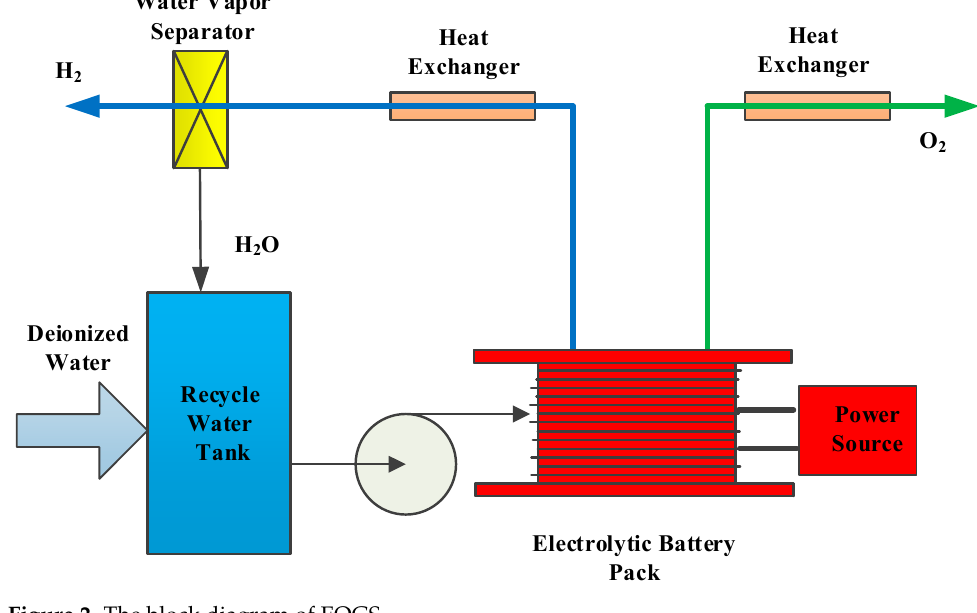
Figure 2. The block diagram of EOGS.